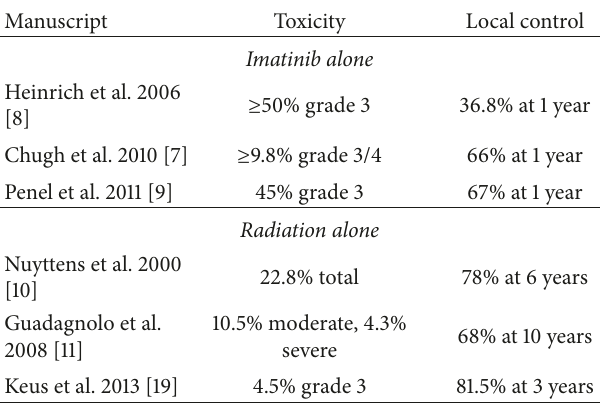
Table 2: Selected previous studies of desmoid tumors treated with imatinib or radiation therapy